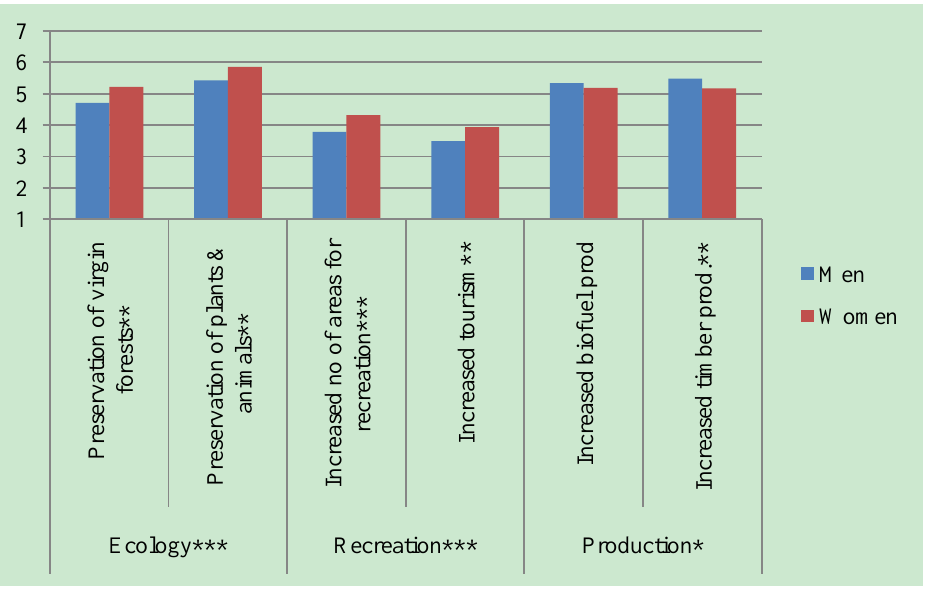
Figure 4. Forest management attitudes among men and women. *** p < 0.001, ** p < 0.01, * p <